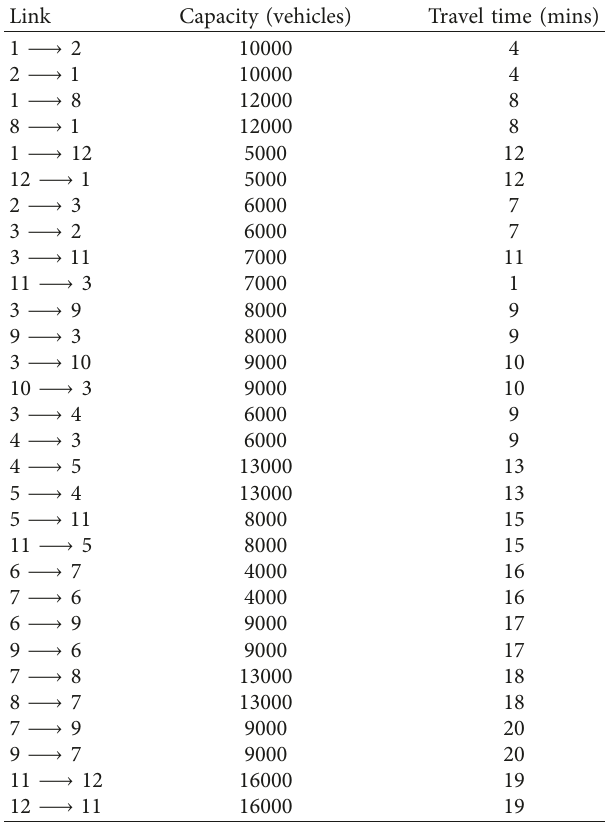
Figure 3: Case examined. Table 3: Free flow capacity and travel